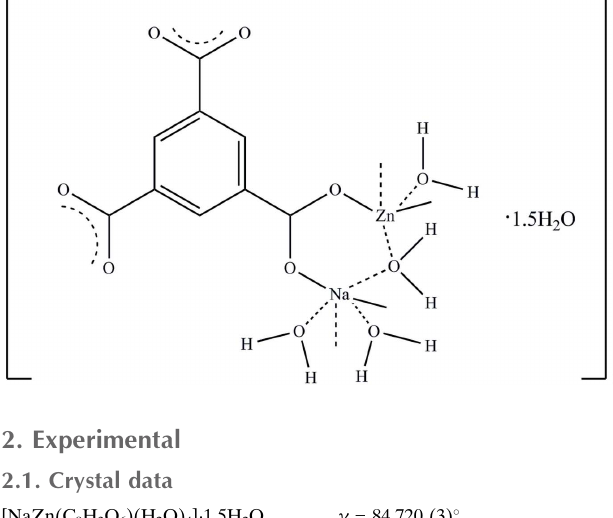
liquid microemulsion at room temperture by the reaction of benzene-1,3,5-tricarboxylic